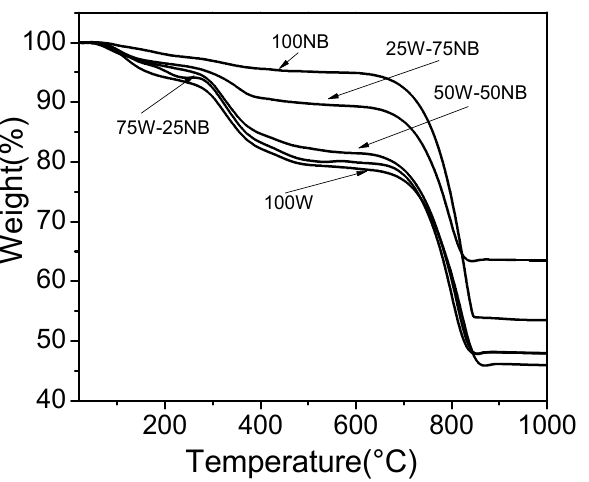
Figure 4. Thermograms of biogenic CaCO 3 using different proportions of whey in nutrient broth.